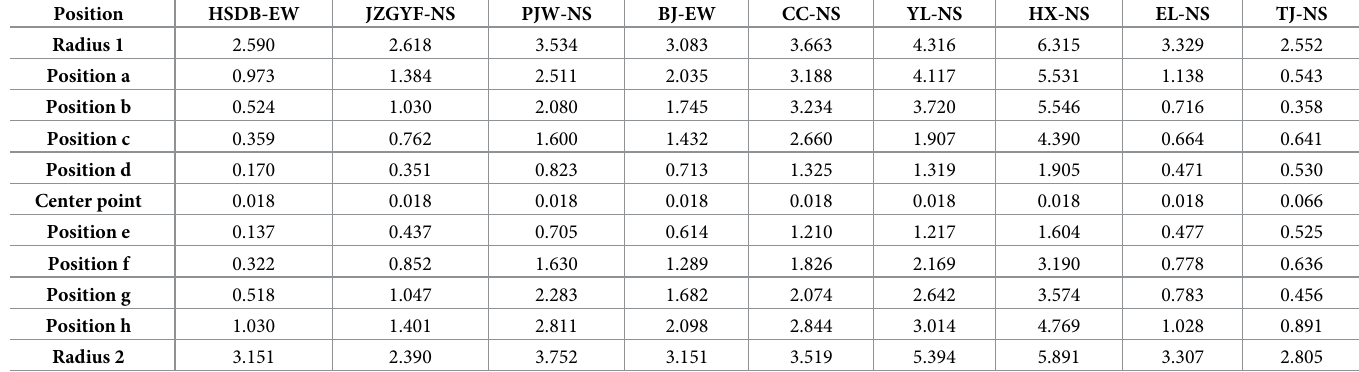
Table 10. The maximum hydrodynamic pressure of the radial direction for tank bottom under unidirectional main seismic motion with 1.0 m/s 2 peak acceleration for A-50% condition (KPa).